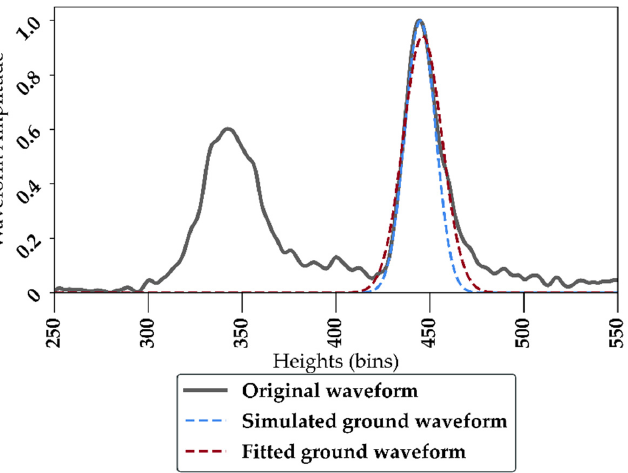
Figure 6. Difference between a simulated ground waveform (dashed blue line) and fitted ground waveform (dashed red line) over an Eucalyptus stand, with a terrain slope of 18.36° (33.2%).